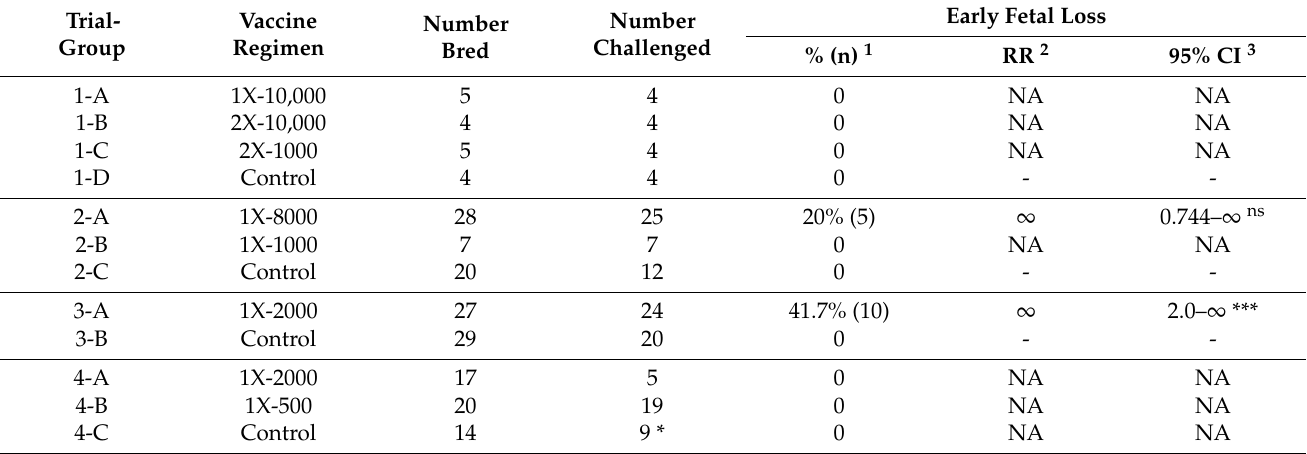
Table 2. Early fetal losses: previously pregnant dams that were open 3 to 7 months into